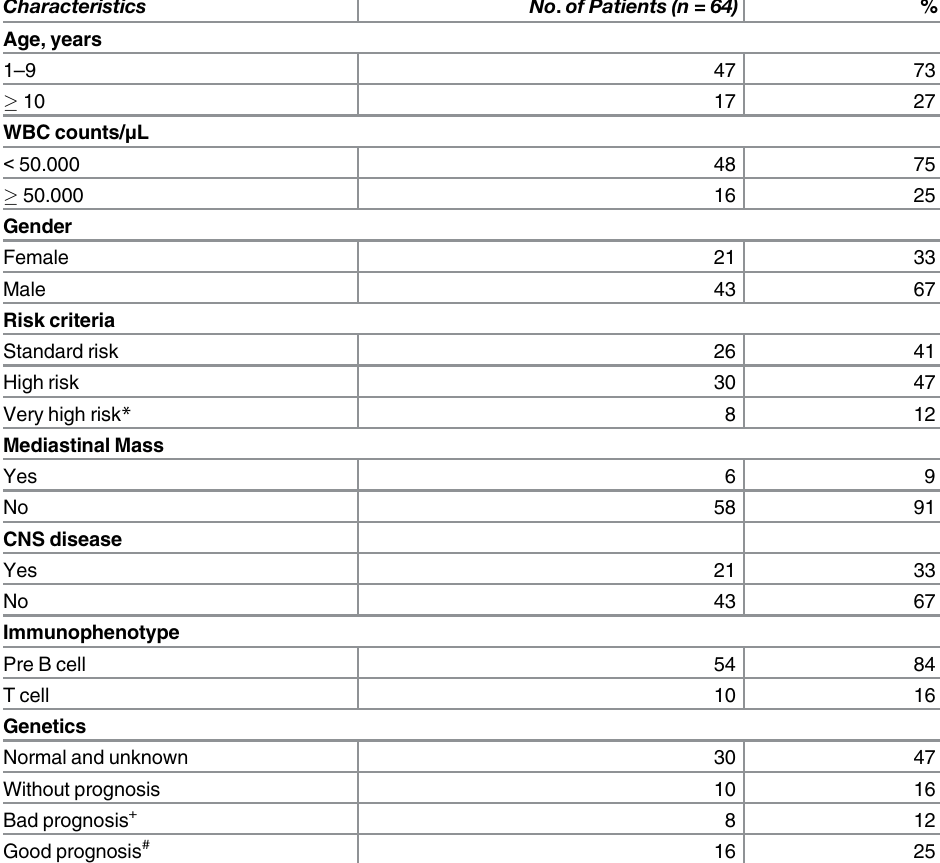
Table 1. Characteristics at first presentation of ALL patients who subsequently relapsed or were refractory to first-line induction.